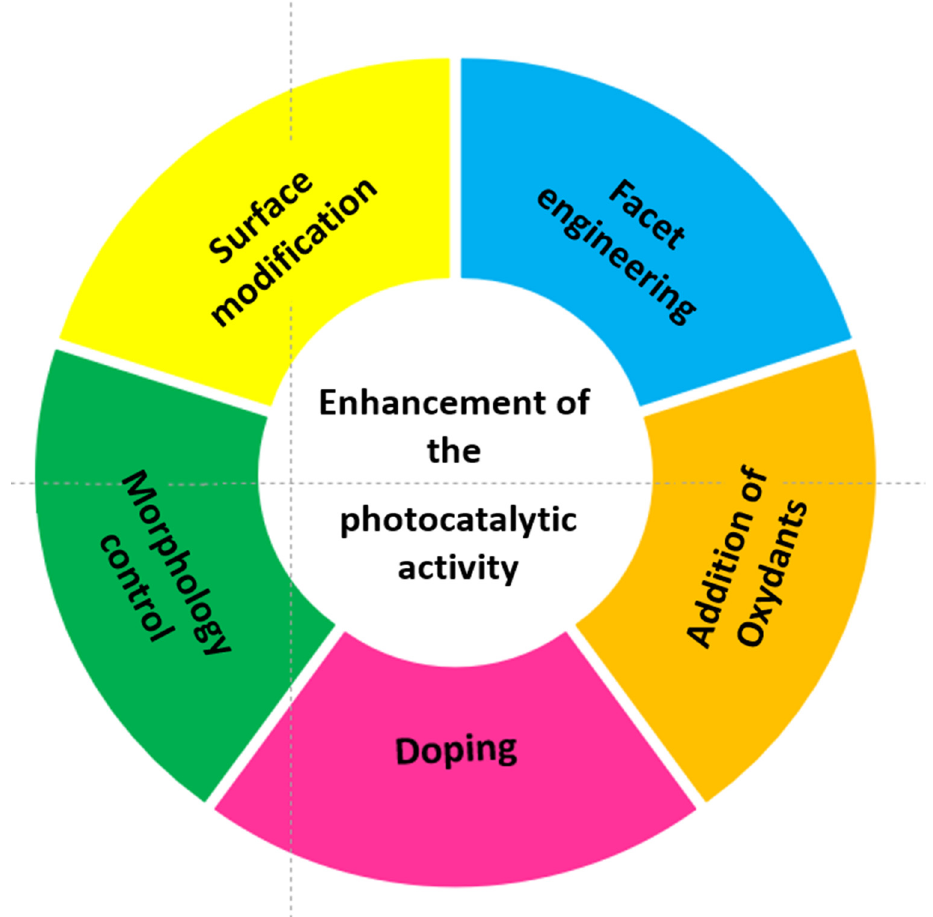
Figure 5. Strategies to enhance the photocatalytic